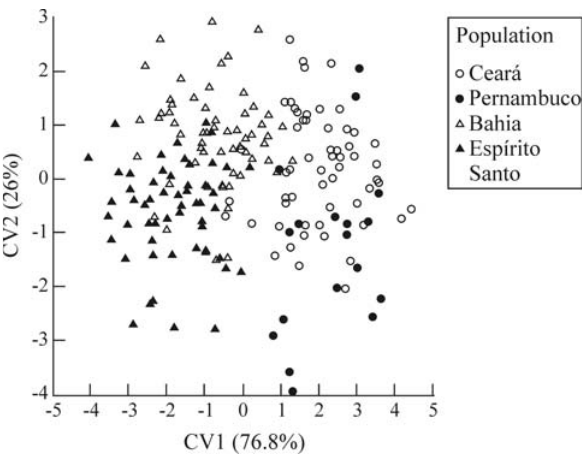
Figure 3 - Scatter plot of individual scores from the first two canonical